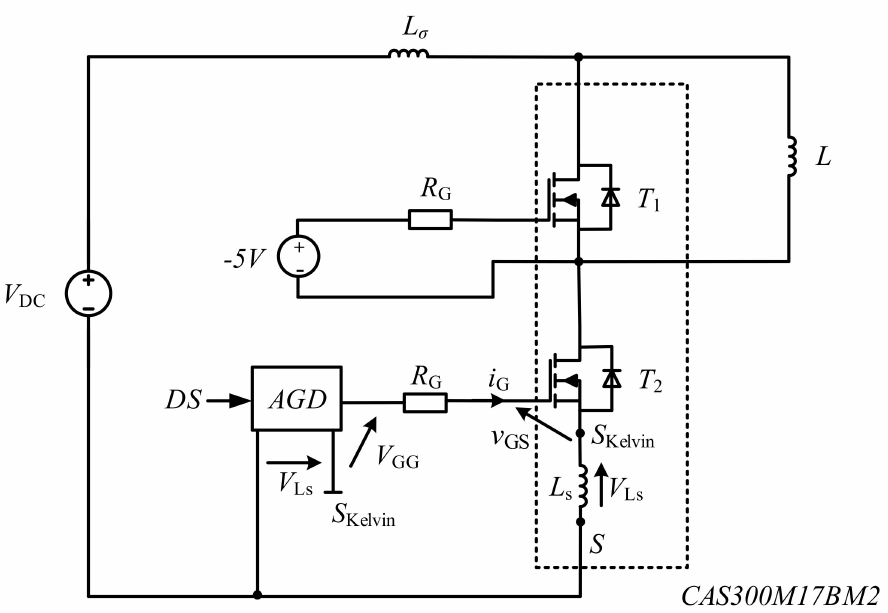
Figure 3. The AGD in DPT setup with half-bridge module 1.7 kV/325 A SiC MOSFET